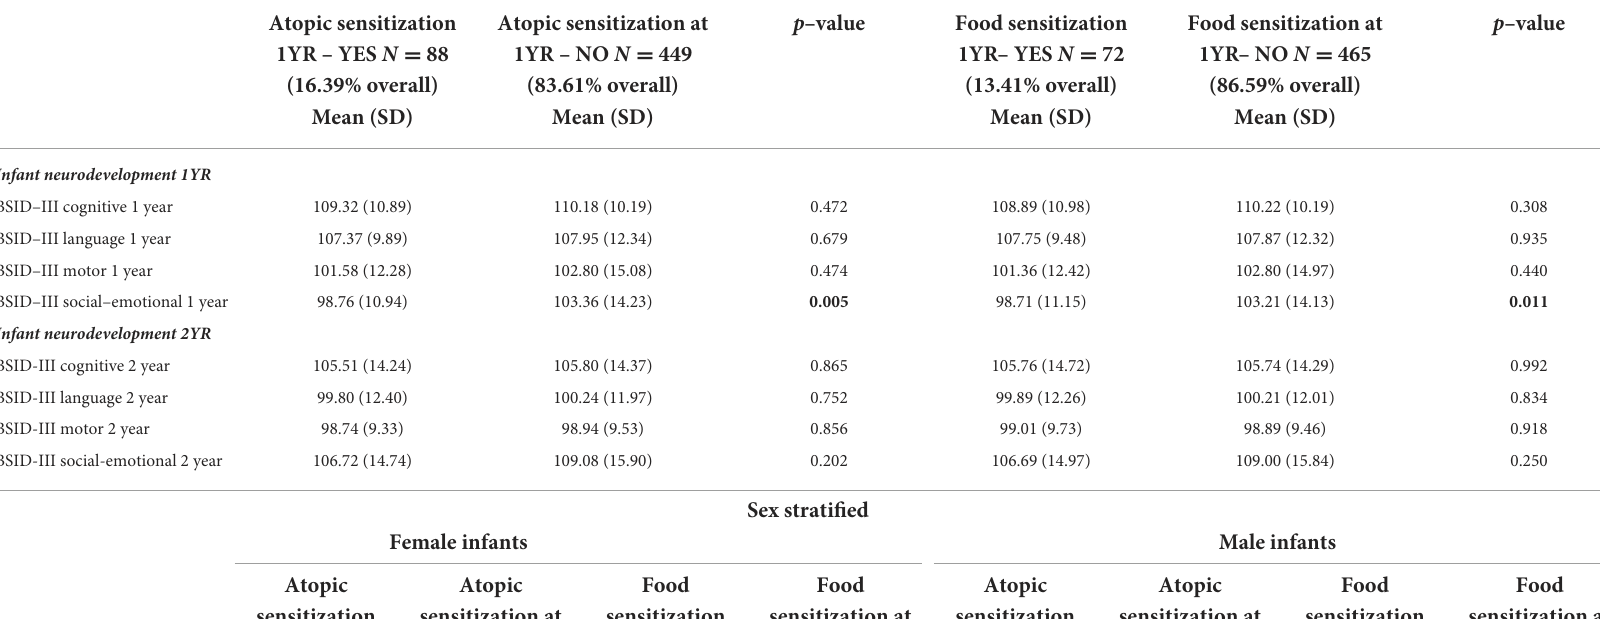
TABLE 1 Comparison of mean scores for neurodevelopmental domains at age 1 and 2 years across atopic and food sensitization status at 1 year, all infants and stratified by infant sex. All